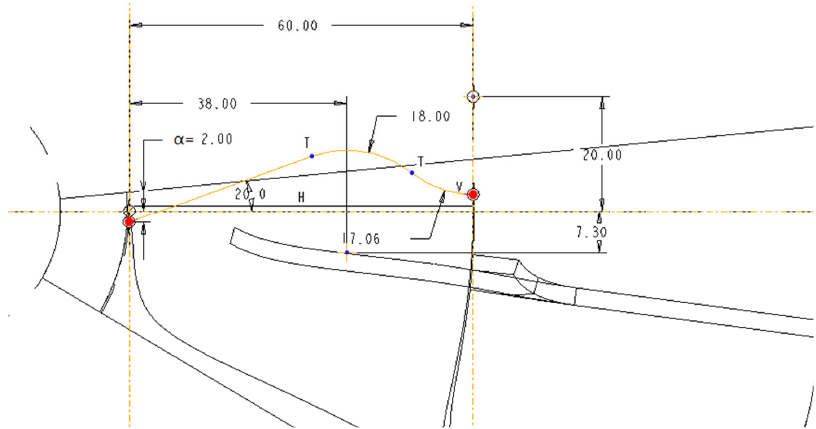
Figure 5. Design size of type B.